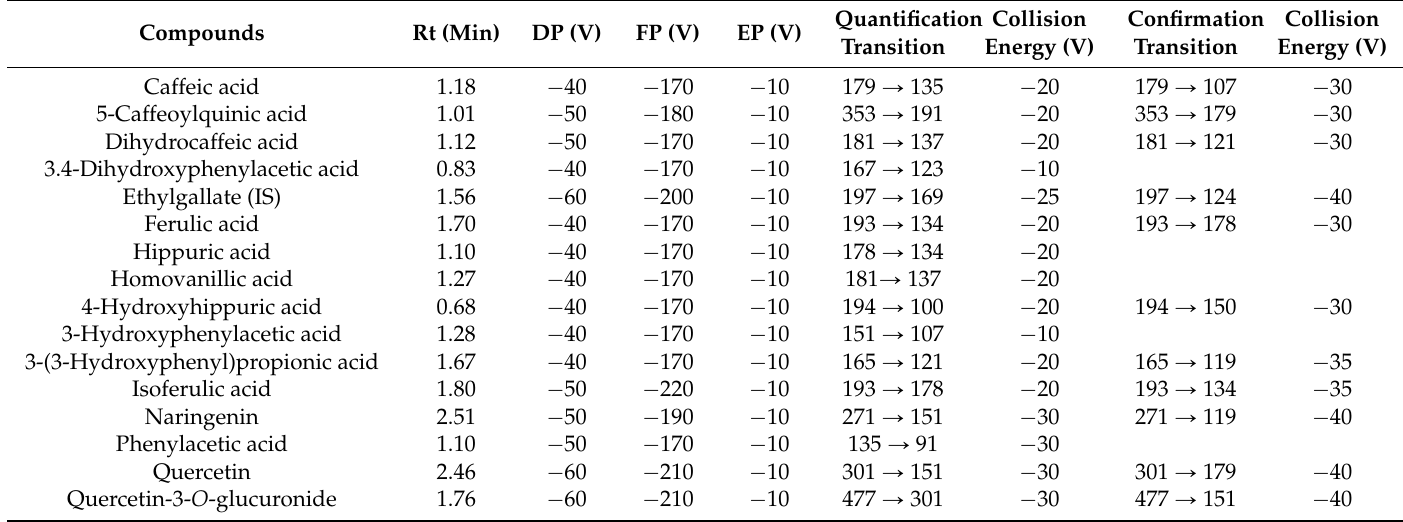
Table 2. Rt (Retention time), Declustering potential (DP), focusing potential (FP) and entrance potential (EP) optimized. Quantification and confirmation transitions of the phenolic compounds with the optimum collision energy